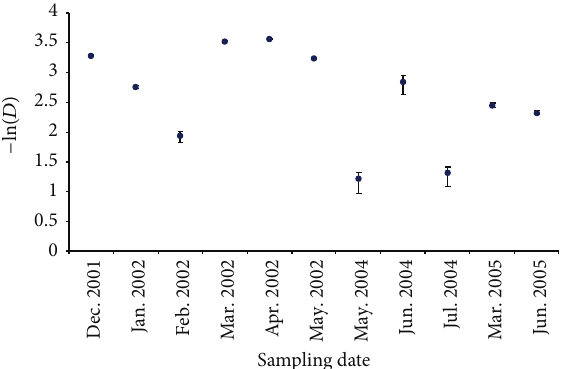
Figure 5: Values of the Simpson index ( − ln 𝐷 ) in the different sampled seasons (confidence interval